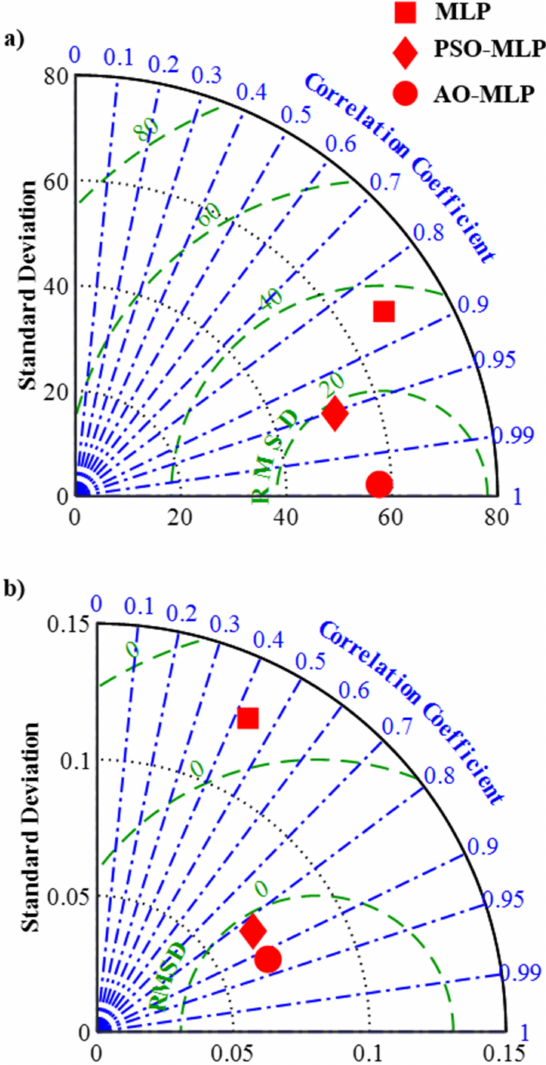
Figure 5. Taylor diagrams of predicted data using MLP, PSO-MLP, and AO-MLP and target ones for: ( a ) shear strength and ( b ) seam